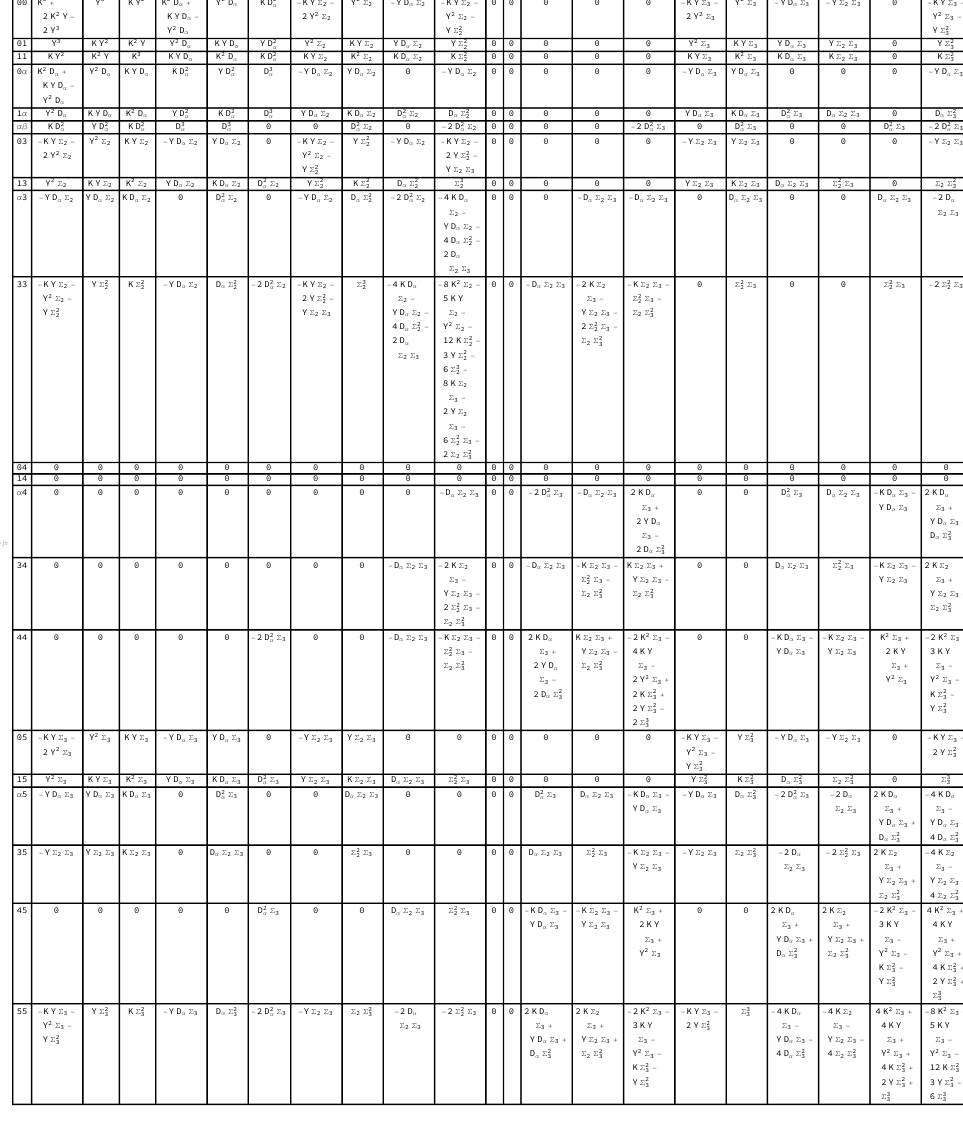
Table 4 . Matrix of pushforwards of quadruple intersection numbers M ˆ that S := ˆ D D J ) associated to the resolution X 5 of the (SU(3) × SU(2) × U(1)) / Z 6 model. The IJ I · entries of the uppermost (leftmost) row (column) are the indices IJ of the corresponding classes ˆ ˆ where ˆ D S IJ . We work in the basis D I =0 , 1 ,α,i D 1 are the rational sections, 0 , s ˆ of a divisor in B , and ˆ D are (resp.) the su (2) , su (3) Cartan divisors. We omit the · D i i 2 =3 , 3 =4 , 5 notation indicating the intersection product for brevity and use the shorthand D 2 D α · D β · D γ